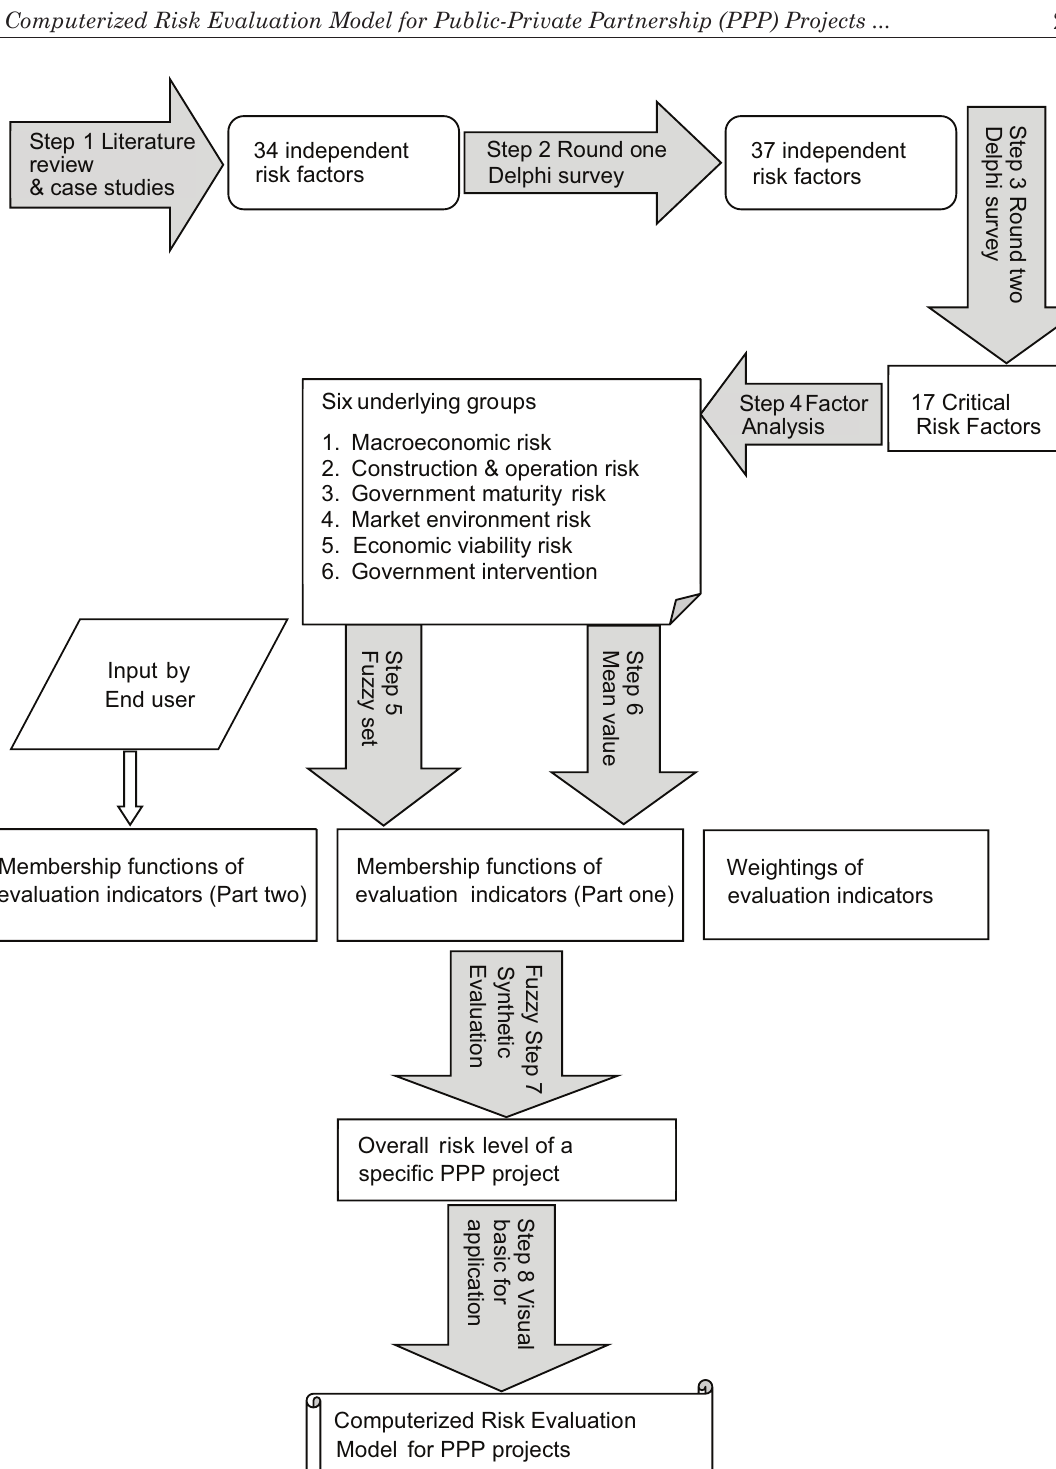
figure 1. framework of developing a computerized risk evaluation model for PPP